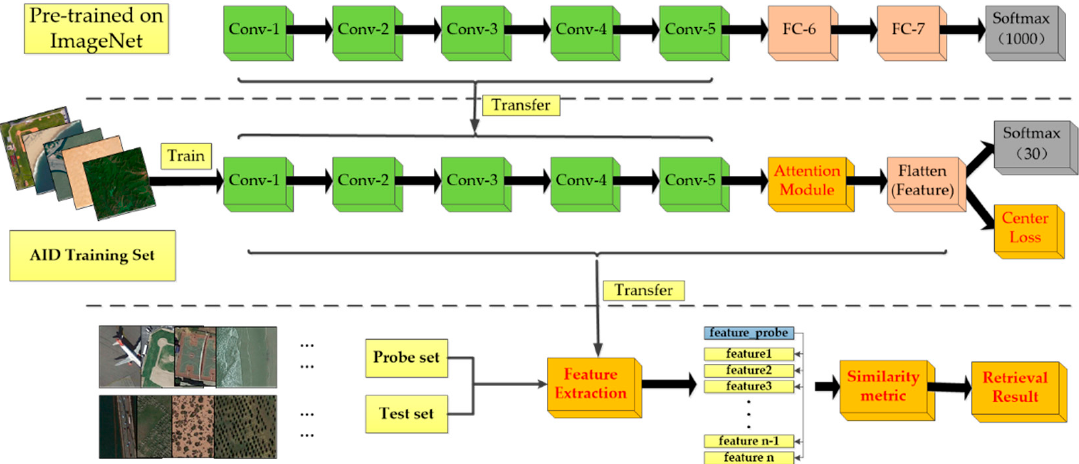
Figure 2. The framework of our proposed discriminative feature learning approach.